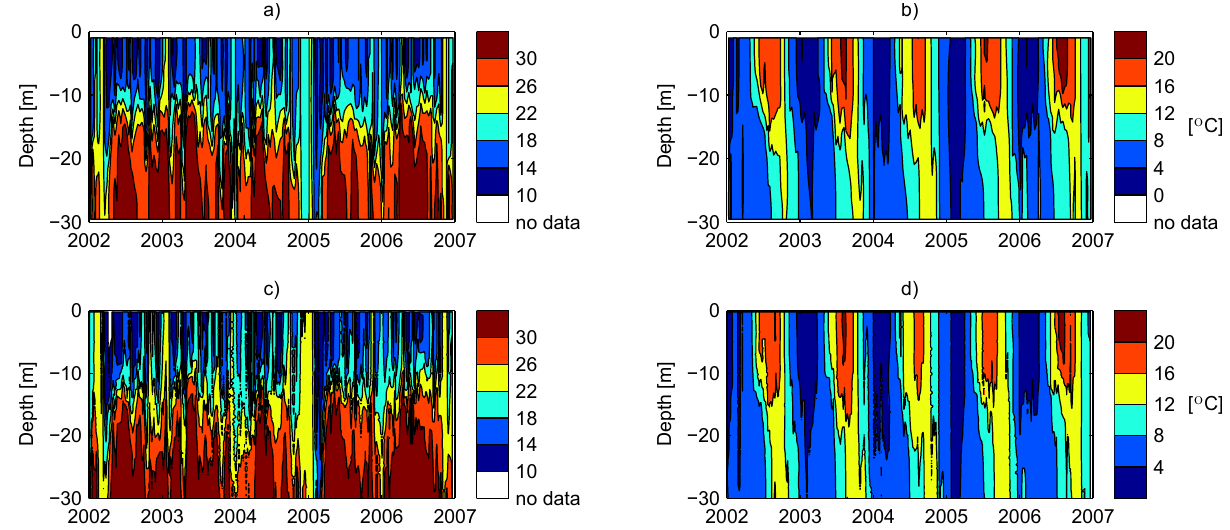
Fig. 3. Simulated and observed salinity and temperature for station “gb” in Great Belt: (a) modelled salinity, (b) modelled temperature, (c) observed salinity, (d) observed